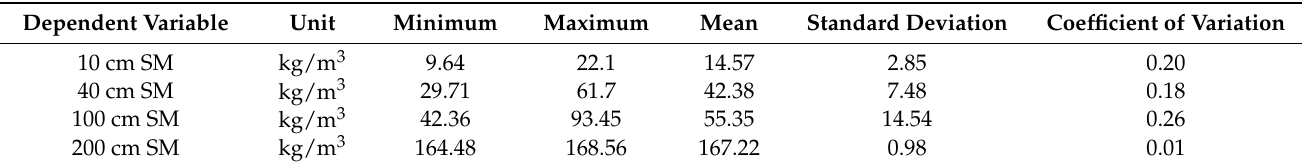
Table 3. Descriptive statistics of the soil moisture data at different depths, from January 2012 to March